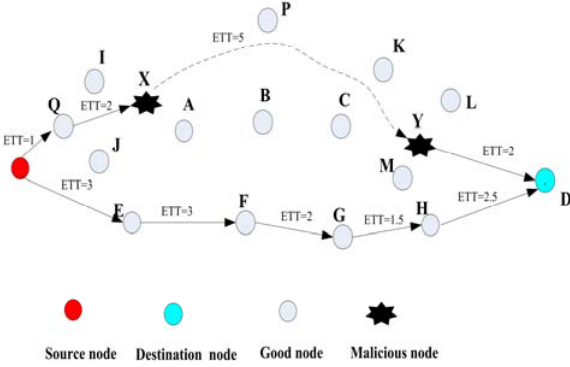
Fig.1. Wormhole Attacks Using Out-of-Band